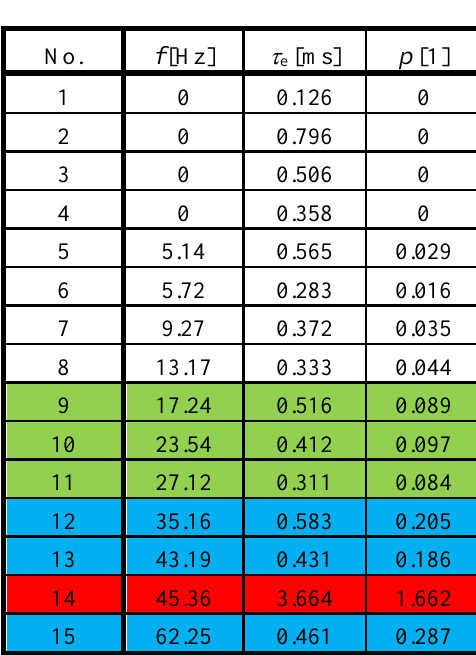
Table 1. OPD modes.